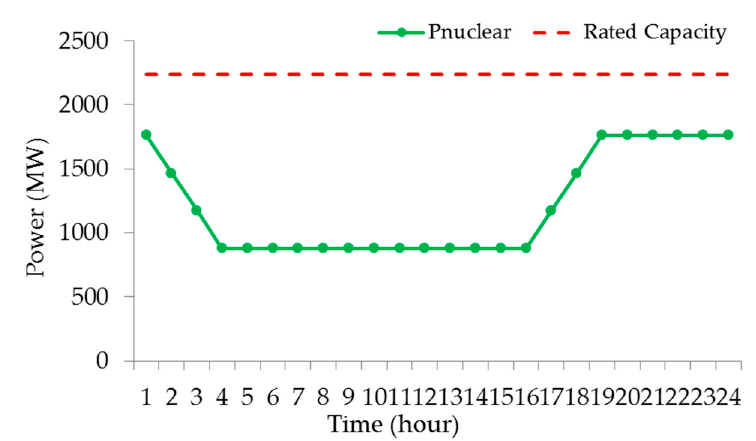
Figure 12. Nuclear power outputs in Case 3.